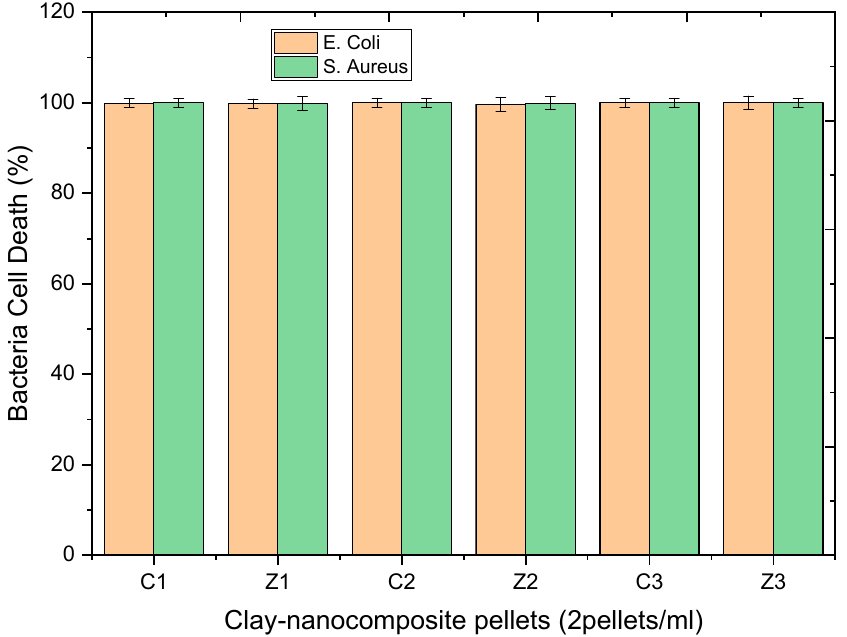
Figure 27. Histogram of the antibacteria activity of clay–nanocomposites pellets against E. coli and S. aureus in sterile aqueous media after 48 h of incubation. C1, C2, C3, Z1, Z2 and Z3, respectively relates to: clay/CuO/Ag-1, clay/CuO/Ag-2, clay/CuO/Ag-3, clay/ZnO/Ag-1, clay/ZnO/Ag-2 and clay/ZnO/Ag-3.